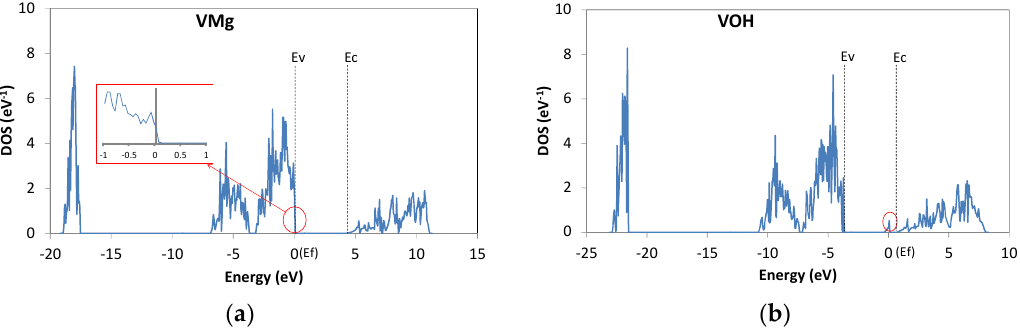
Figure 2. Density of states (DOS) of Mg(OH) 2 with ( a ) Mg vacancy V Mg and ( b ) OH vacancy V OH .